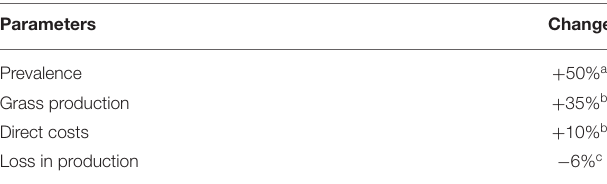
TABLE 2 | Change parameters used in the model under the “ disease + CC ” scenario compared to the baseline